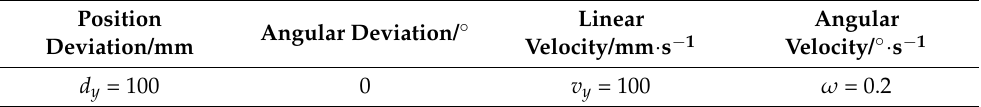
Table 2. The initial docking conditions of the simulation analysis without angular devitaion.